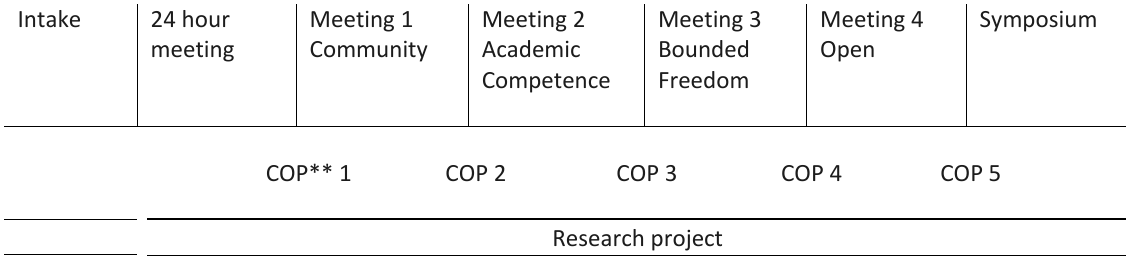
Figure 2. Time schedule